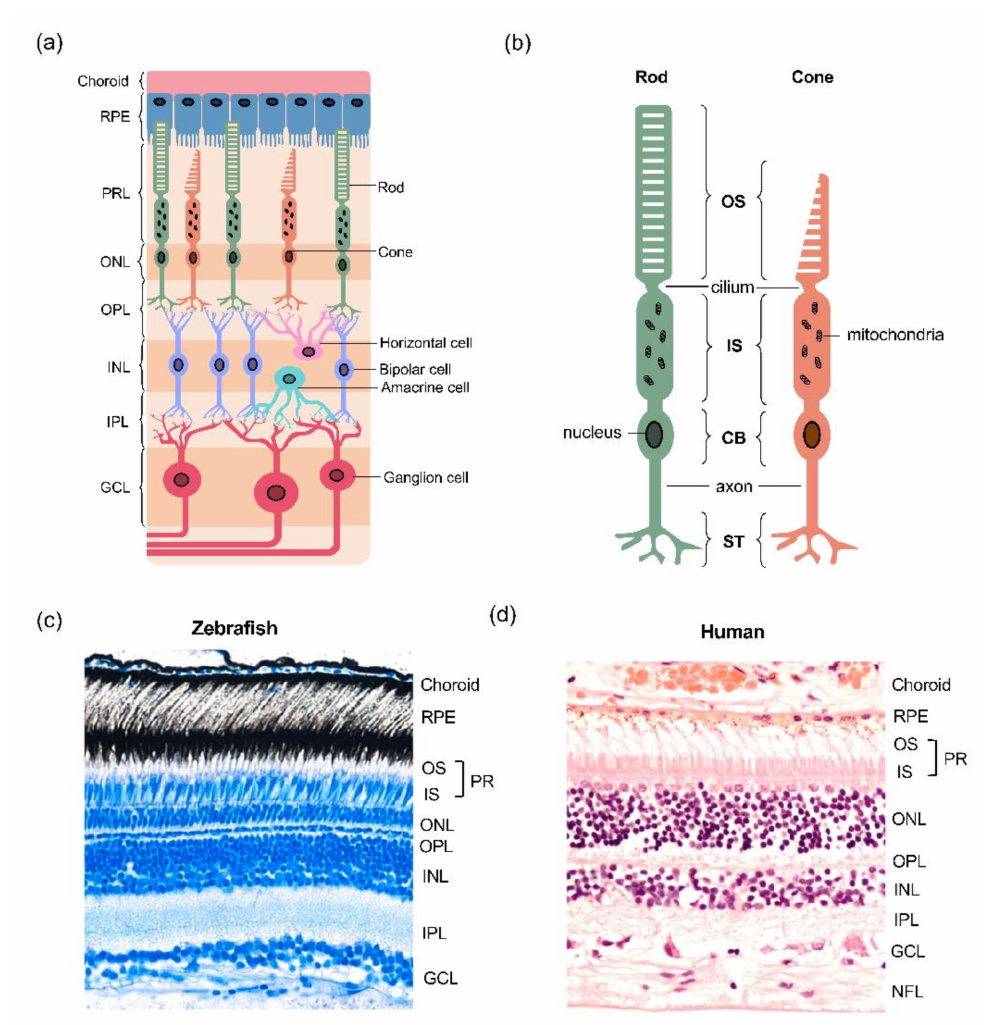
Figure 1. Structural features of the vertebrate retina. ( a ) Overview of the multicellular layered retina. The retinal pigment epithelium (RPE) sits between the photoreceptor layer (PRL) in the outer retina and the choroidal vasculature. The cell bodies of rod and cone photoreceptors are located in the outer nuclear layer (ONL) and form synapses with horizontal and bipolar cells in the outer plexiform layer (OPL). The inner nuclear layer (INL) contains the cell bodies of horizontal, bipolar and amacrine cells, the latter two forming synapses with retinal ganglion cells (RGC) in the inner plexiform layer (IPL); ( b ) structure of the rod and cone photoreceptors. Both photoreceptor types have a light-sensitive outer segment (OS) connected to the inner segment (IS) by a single connecting cilium. The IS is abundant in megamitochondria, an adaptation that maximises energy production. The cell body contains the nucleus and protein synthesis machinery, and the axon separates the cell body (CB) from the synaptic terminals (ST), whilst transmitting the action potential that triggers glutamate neurotransmission release from ST; ( c , d ) a comparison of the structure of the human and zebrafish